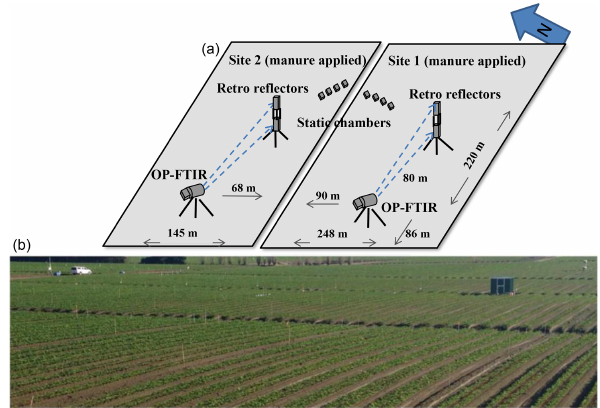
Figure 1. The design of the study (a) and photo of experimental site with OP-FTIR set up (b) . Emission measurements were conducted with static chambers (four per site) and FG using the OP-FTIR spec- troscopy system with retro reflectors at 0.8 and 1.8m above ground. The figure is not to